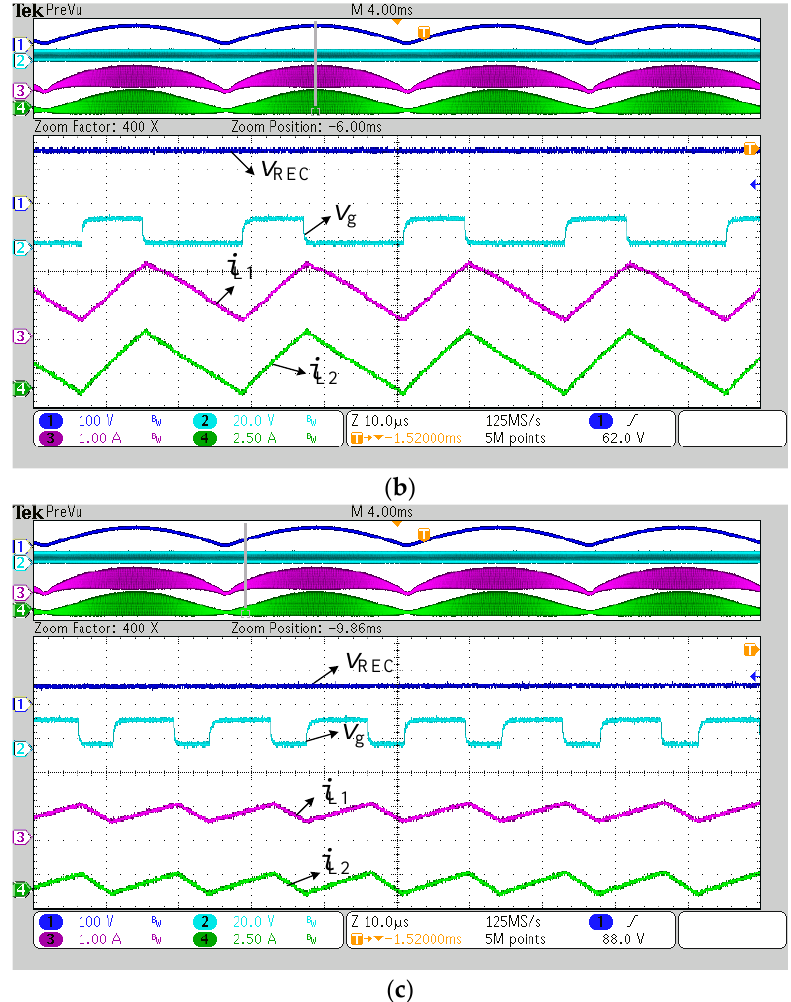
Figure 21. Experimental waveforms of v REC , v g , i L 1 , and i L 2 of COT control with 110 Vac input voltage and rated output current. ( a ) overall waveform; ( b ) zoomed-in waveform at ωt = π/2, i.e., v Rec is 155 V; ( c ) zoomed-in waveform around zero-cross point of input voltage, v Rec is 50 V.